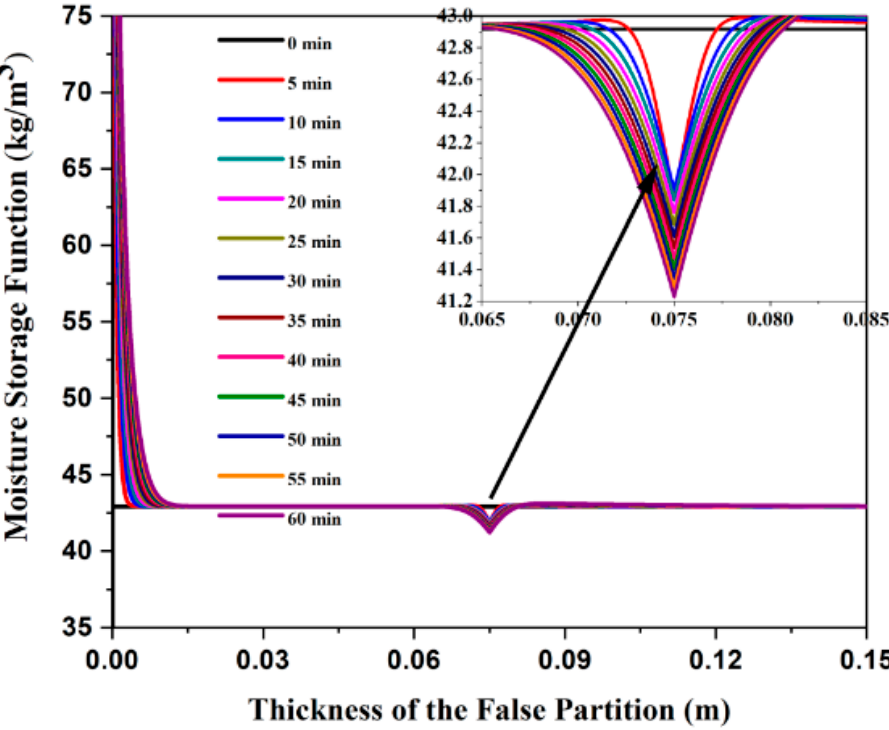
Figure 5. Moisture profile of the false partition.